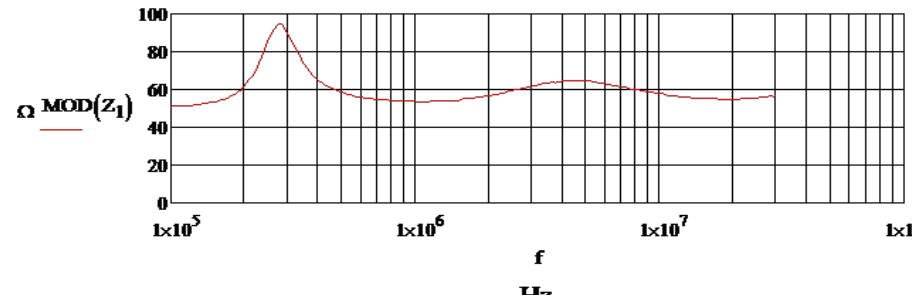
Figure 2. Characteristics of ferrite No. 2.